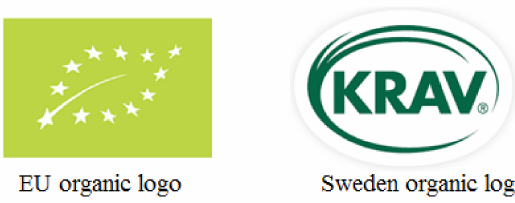
Figure 1. Examples of logos that can be used for organic